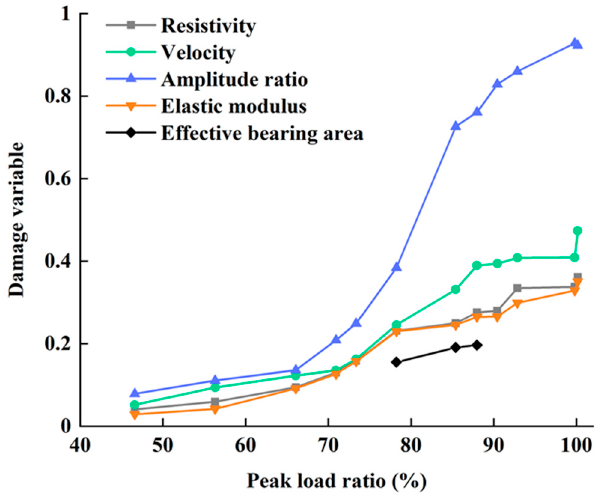
Figure 12. Damage variables derived from different measurement parameters. Note that three specimens were tested using a CT scan. specimens were tested using a CT